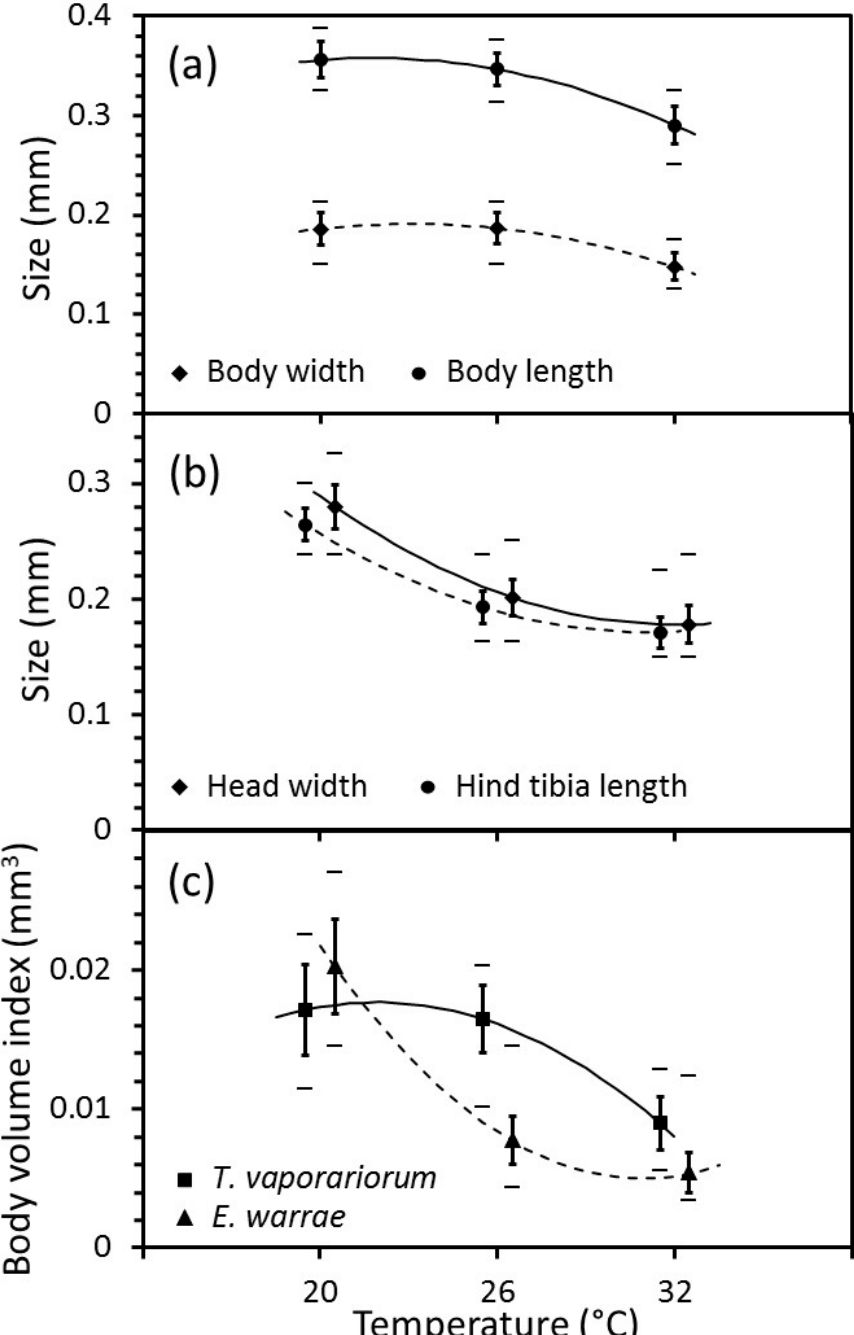
Figure 2. E ff ects of temperature on the body-sizes of Trialeurodes vaporariorum and Eretmocerus warrae . ( a ) Length and width of second instar T. vaporariorum . ( b ) Head width and hind-tibia length of adult E. warrae . ( c ) Body-volume indices of T. vaporariorum and E. warrae . Values are mean ± standard deviation (standard errors are too small to show on picture). Values of E. warrae are offset by ±0.5 °C in ( b , c ) to assist visualisation. Quadratic regression lines and regression models are shown ( p < 0.001).